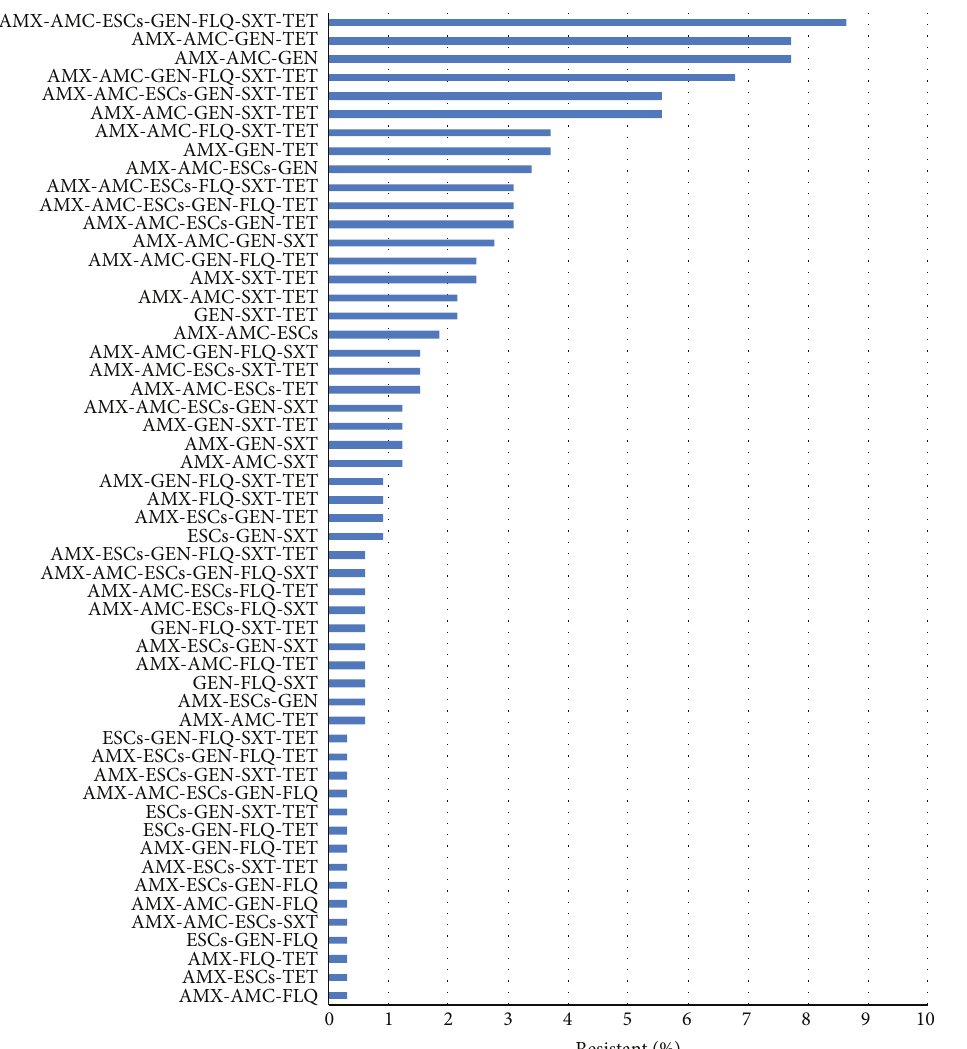
Figure 3: Multidrug resistance phenotypes in canine and feline MDR E. coli isolates ( 𝑛 = 324 ). AMC: amoxicillin/clavulanic acid (the representative of penicillin with 𝛽 -lactamase inhibitor), AMX: amoxicillin (the representative of penicillin), ESCs: the extended-spectrum cephalosporins, FLQ: fluoroquinolones, GEN: gentamicin (the representative of aminoglycosides), SXT: sulfamethoxazole/trimethoprim (the representative of folate pathway inhibitors), and TET: tetracycline (the representative of tetracyclines).